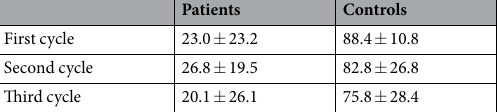
Table 2. Scores for each